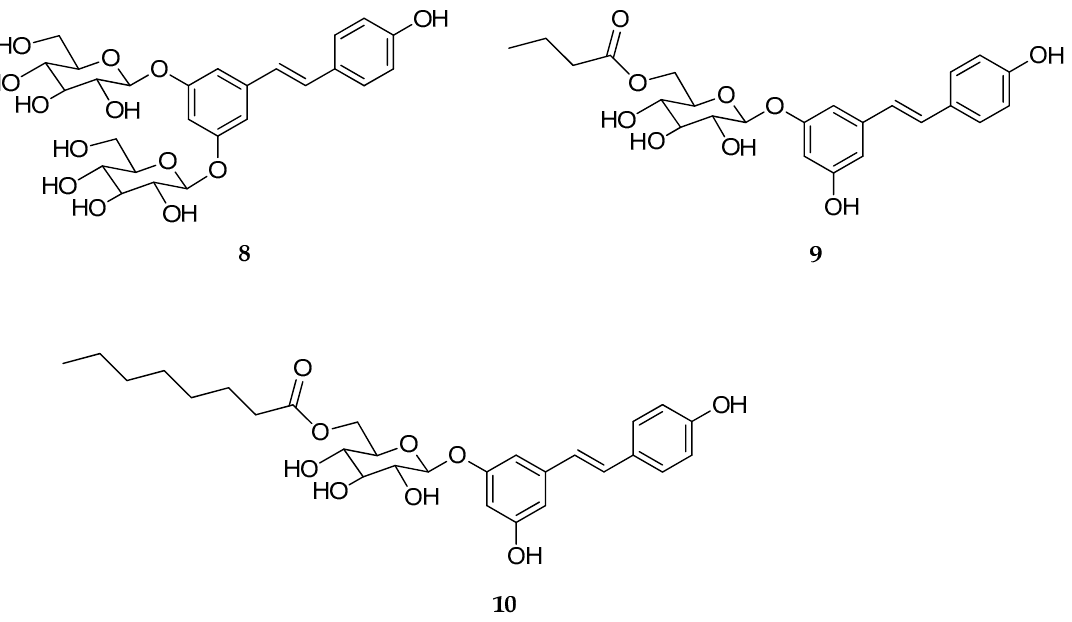
Figure 6. Chemical structures of RSV-3,5-di-O- β -D-glucopyranoside ( 8 ), RSV-3-O-(6 ′ -O-butanoyl)- β -D-glucopyranoside ( 9 ), RSV-3-O-(6 ′ -O-octanoyl)- β -D-glucopyranoside ( 10 ).